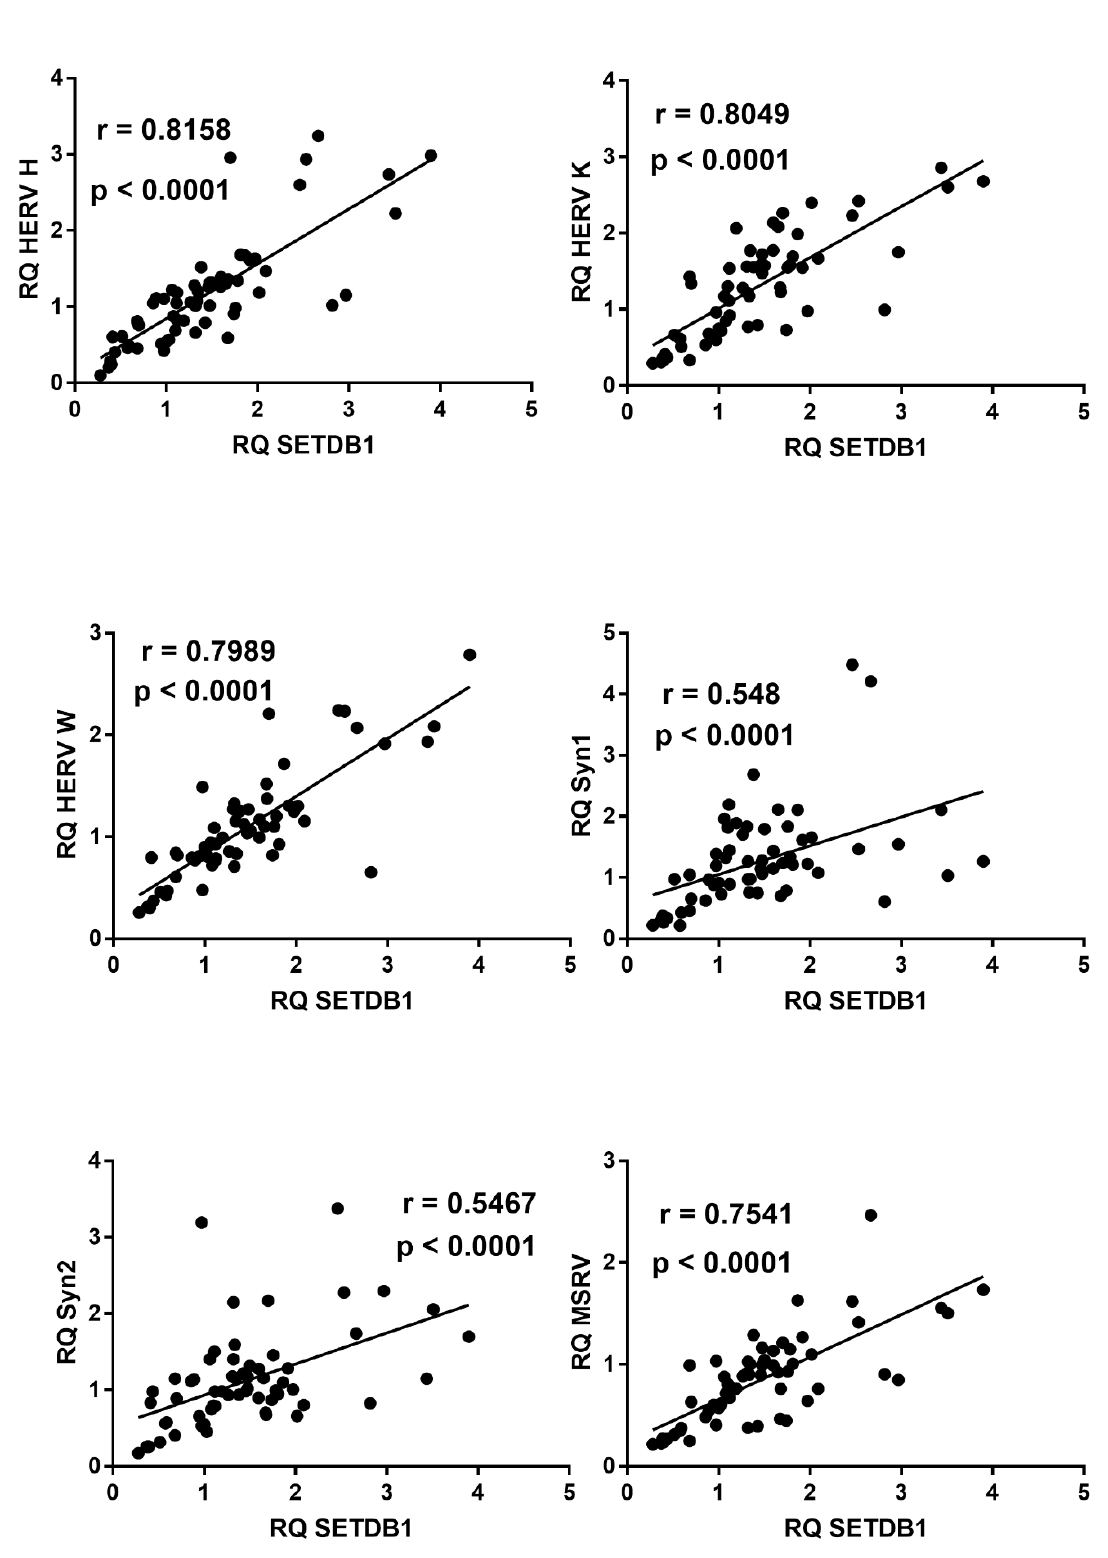
Figure 10. Correlations between transcription levels of SETDB1 and HERV sequences in whole blood from 64 COVID-19-infected children. RQ: relative quantification. Circles show the mean of three individual measurements. Line: linear regression line. Statistical analysis: Spearman correlation test.